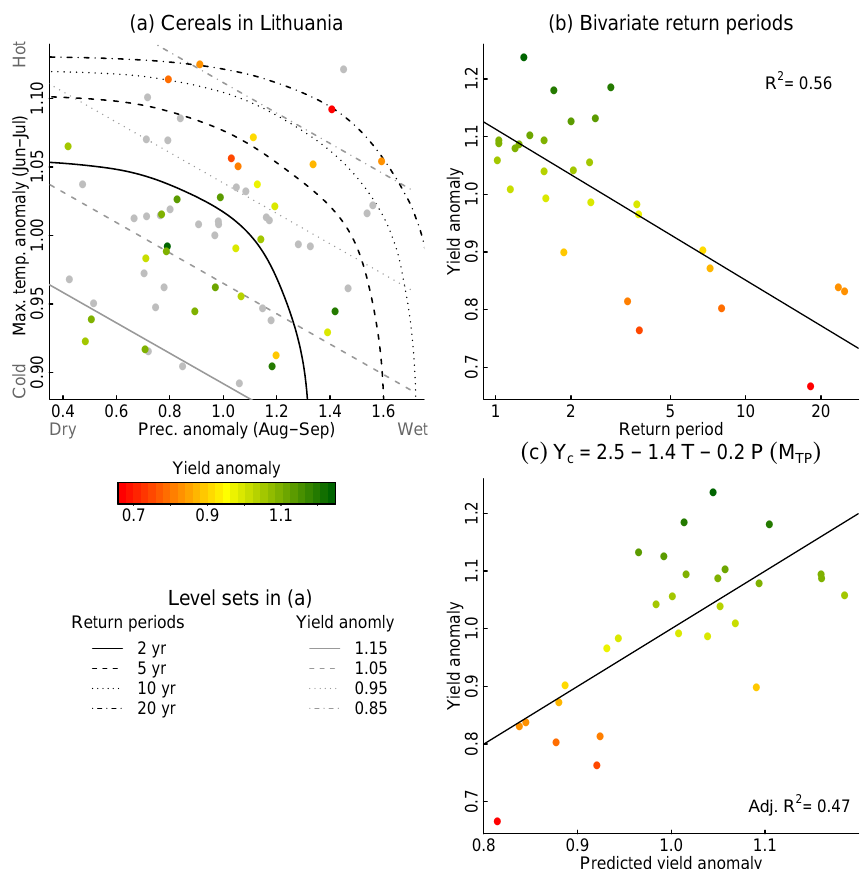
Figure 2. Cereals in Lithuania, similar to Fig. 1. (a) Maximum temperature anomalies averaged over June and July vs. precipitation anomalies averaged over August and September. Dots are coloured according to cereal yield anomalies if yield data were available and are grey otherwise. Dry and cold conditions are on the lower left. (b) Cereal yield anomaly vs. bivariate return periods. The line indicates the best linear fit with R 2 = 0 . 56. (d) Linear model using predictors from (a) ( M TP ). The adjusted R 2 is 0.47. The line denotes the 1:1